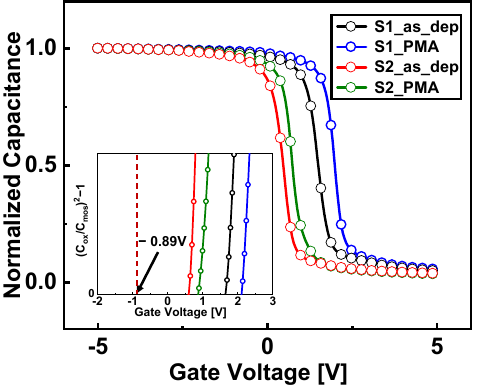
Figure 3. Normalized capacitance vs. voltage graph and graphical ((C OX /C MOS ) 2 − 1)(V G ) method to extract the flat-band voltage (V fb ) of Al 2 O 3 samples with and without PMA (frequency = 1 MHz). V fb increased by 0.54 V after PMA in the case of Al 2 O 3 samples with short O 2 plasma exposure times. Internal defects that form bonds with carbon impurities have a negative charge and diffuse toward Si [10,14]. However, in the case of S2 samples with long O 2 plasma exposure times, the change in V fb was as small as 0.2 V owing to a decrease in the defects that can be diffused. The permittivity of Al 2 O 3 samples before and after PMA is shown in Figure 4. The permittivity is 9.5 in the case of the as-deposited S1 sample, which is similar to the gener- ally known permittivity value of amorphous Al 2 O 3 (6–9) [18,20]. However, an IL of SiO X (x = 1–2) is formed between Al 2 O 3 and Si after PMA, slightly decreasing the permittivity. The permittivity of the as-deposited S2 sample is 12.5, which is considerably higher than that of the S1 sample. This is because of the decrease in the content of various defects and the increase in the internal carbon concentration owing to the longer O 2 plasma exposure time. After PMA on the as-deposited S2 sample, the permittivity decreases to 10.5 because an IL of SiOx (x = 1–2) is formed between Al 2 O 3 and Si like the S1 sample. However, the S2_PMA sample still showed a higher permittivity than the S1 samples with shorter O 2 plasma exposure time. Figure 4. Permittivity of Al 2 O 3 samples under deposition conditions (O 2 plasma exposure time: 3 and 7 s) and post-metallization annealing (PMA).